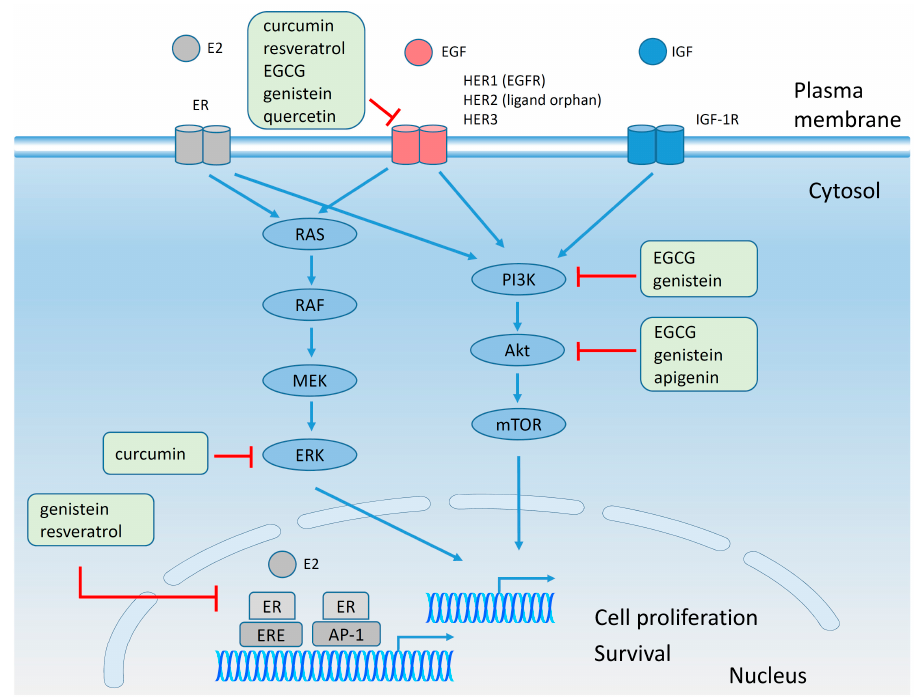
Figure 6. The effect of polyphenols on nuclear ER, HER2 and IGF signaling pathways. Two main mechanisms of E2 action are depicted: (i) genomic activity of nuclear ER in connection with ERE or activating protein-1 (AP-1) transcription factors and (ii) cell surface activity of plasma membrane ER in connection with growth factor receptor signaling pathways [21,139]. Nuclear ER activity might be inhibited by genistein and resveratrol; the expression or phosphorylation of EGFR family can be downregulated by curcumin, resveratrol, quercetin and genistein; ERK phosphorylation can be reduced by curcumin; PI3K activity can be inhibited by EGCG and genistein, while Akt action can be inhibited by EGCG, genistein and apigenin [142–149]. Blue and red lines indicate stimulation and inhibition, respectively (for the sake of simplicity only the major proteins of the signaling pathways were included). Some flavonoids like genistein, daidzein and quercetin are known to exert anti-oxidant, anti-tumor and anti-inflammatory effects through their ability to scavenge free radicals [150] and through their capacity to mimic the effect of estrogens in physiological activities [151]. Administration of 10 µM genistein for 6 days bound to estrogen receptors in MCF-7 cells with a dissociation constant (K d ) of 4 nM and modulated the expression of proteins regulated by ER. Resveratrol influenced the mRNA expression of genes involved in ER signaling pathways with a higher activity in ER+ than ER- breast cancer cells [152]. Additional data about resveratrol indicates that it may activate other pathways